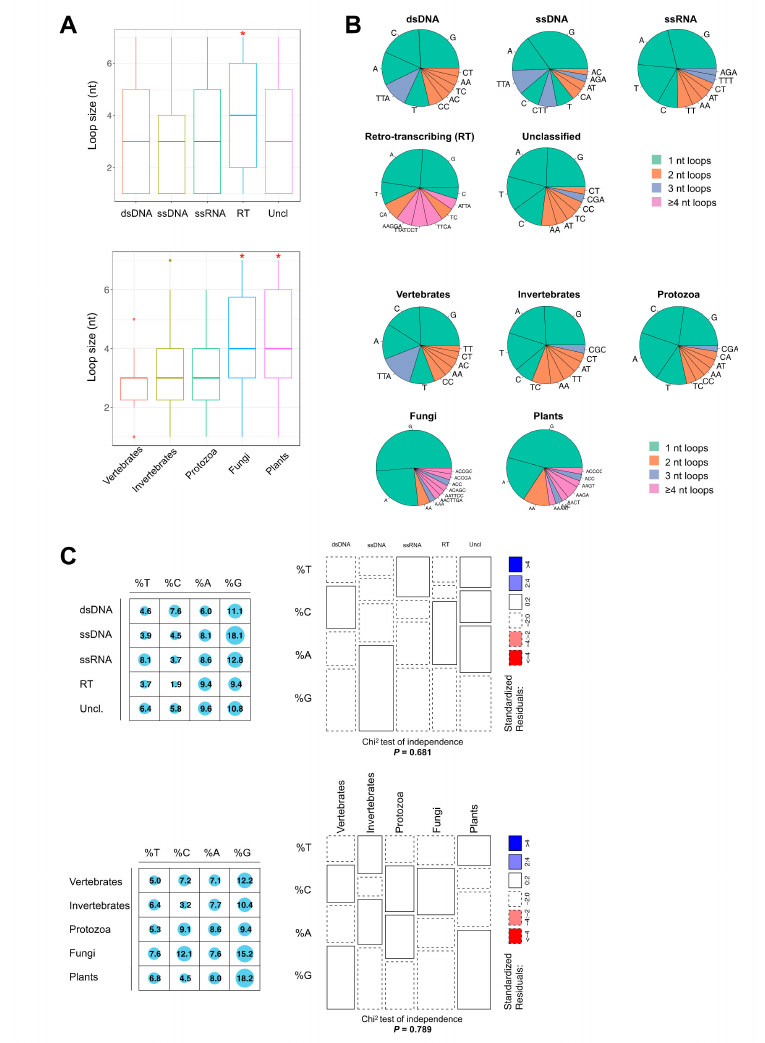
Figure 2. Quadruplex loop composition in viral genomes. ( A ) Boxplots show G-quadruplex (G4) motif loop size (in nucleotides) for each group. Top panel, for di ff erent viral taxa; bottom panel, for di ff erent host groups. Kruskal–Wallis rank sum test P = 0.0001 and P = 8.19 × 10 − 6 respectively; *, all pairwise Wilcoxon rank-sum tests adj P < 0.01. ( B ) Frequencies of 1–7 nucleotide loops, irrespective of their position within the G4 motif. Top panel, five taxa in which a significant number of G4 sequences were found: dsDNA viruses (n = 2758 assemblies, 11,315 PQSs), ssDNA viruses (n = 988 assemblies, 102 PQSs), ssRNA viruses (n = 1784 assemblies, 553 PQSs), Retro-transcribing viruses (n = 153 assemblies, 85 PQSs), and Unclassified viruses (n = 1217 assemblies, 253 PQSs). Bottom panel, five eukaryotic host taxa used in the analyses: vertebrates (n = 2,769 assemblies, 7945 PQSs), invertebrates (n = 2930 assemblies, 1410 PQSs), protozoa (n = 61 assemblies, 618 PQSs), fungi (n = 292 assemblies, 41 PQSs), and plants (n = 2484 assemblies, 261 PQSs). ( C ) Top panel and from left to right, graphical matrix where each cell contains a dot whose size reflects the relative magnitude of nucleotide proportions by viral taxa and mosaic plot of the contingency table used to perform a chi-square independence test (non-significant, P = 0.681); bottom panel and for left panel to right, similar for each host group (chi-square independence test non-significant, P =